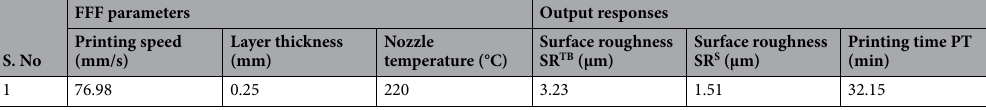
Table 5. RSM predicted results.